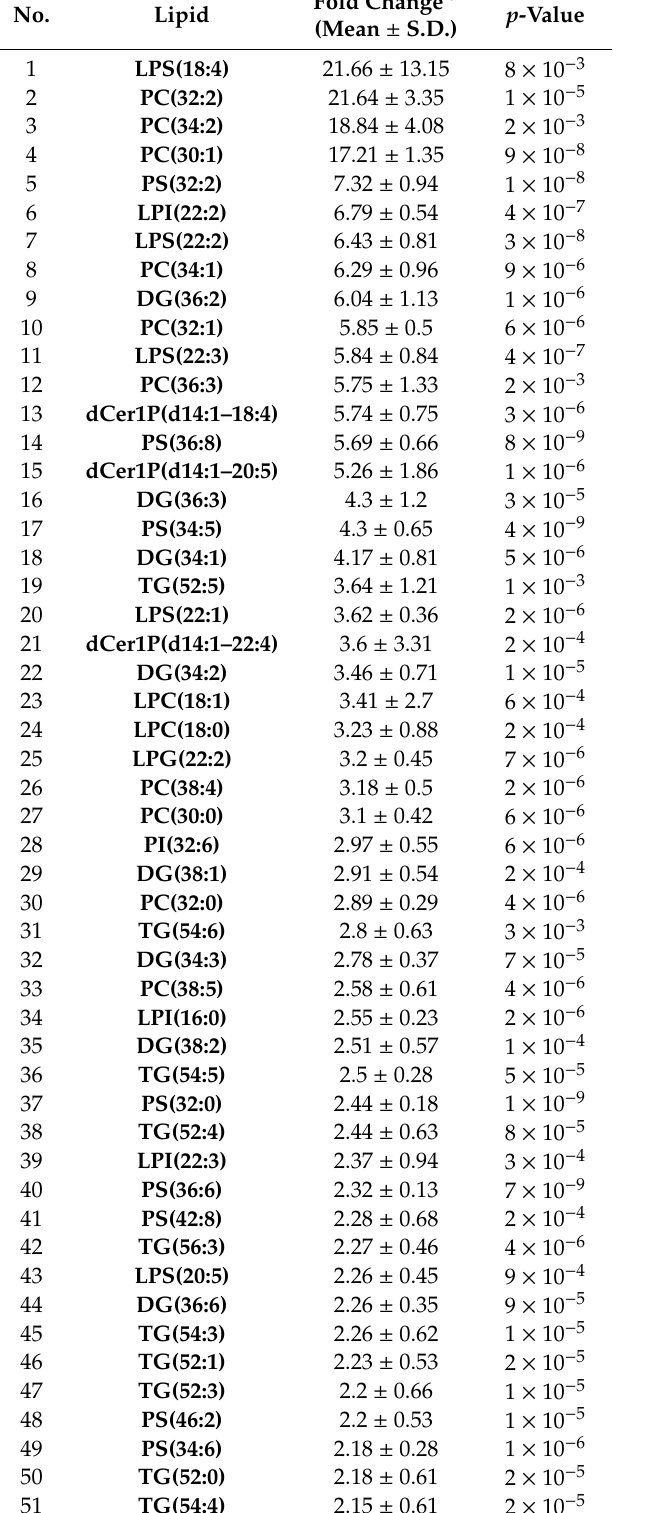
Table 3. The list of di ff erentially increased lipid species in LEVs compared to L. plantarum . The data are shown as mean ± S.D. of the fold increase with p -value ( n = 9 per group; three independent biological replicates and three technical replicates). The list is displayed in descending order of fold change. Statistical significance was analyzed by Student’s t -tests for two